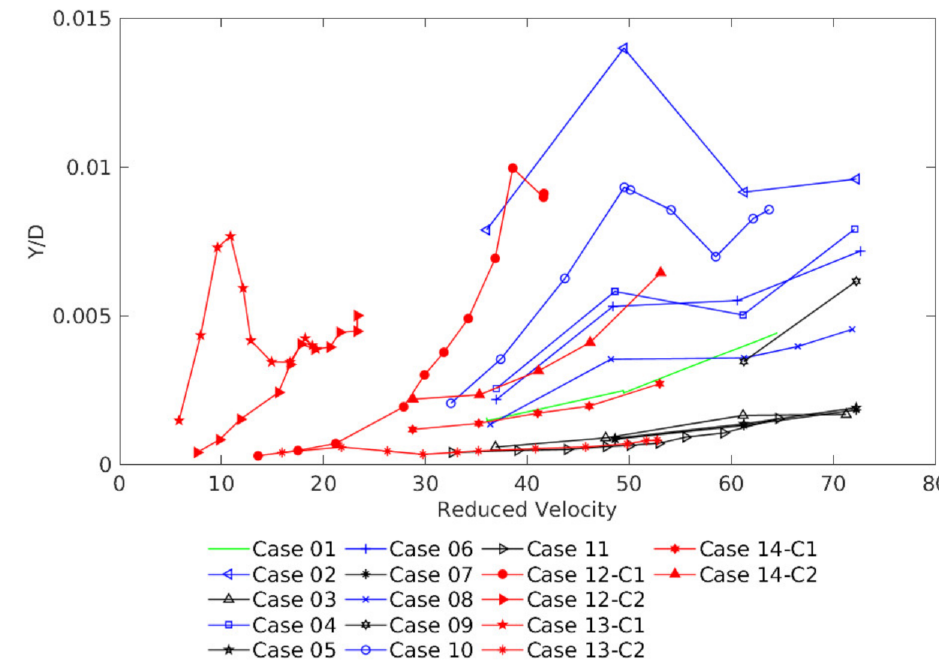
Figure 3. Tested cases: non-dimensional displacement (Y/D) versus reduced velocity